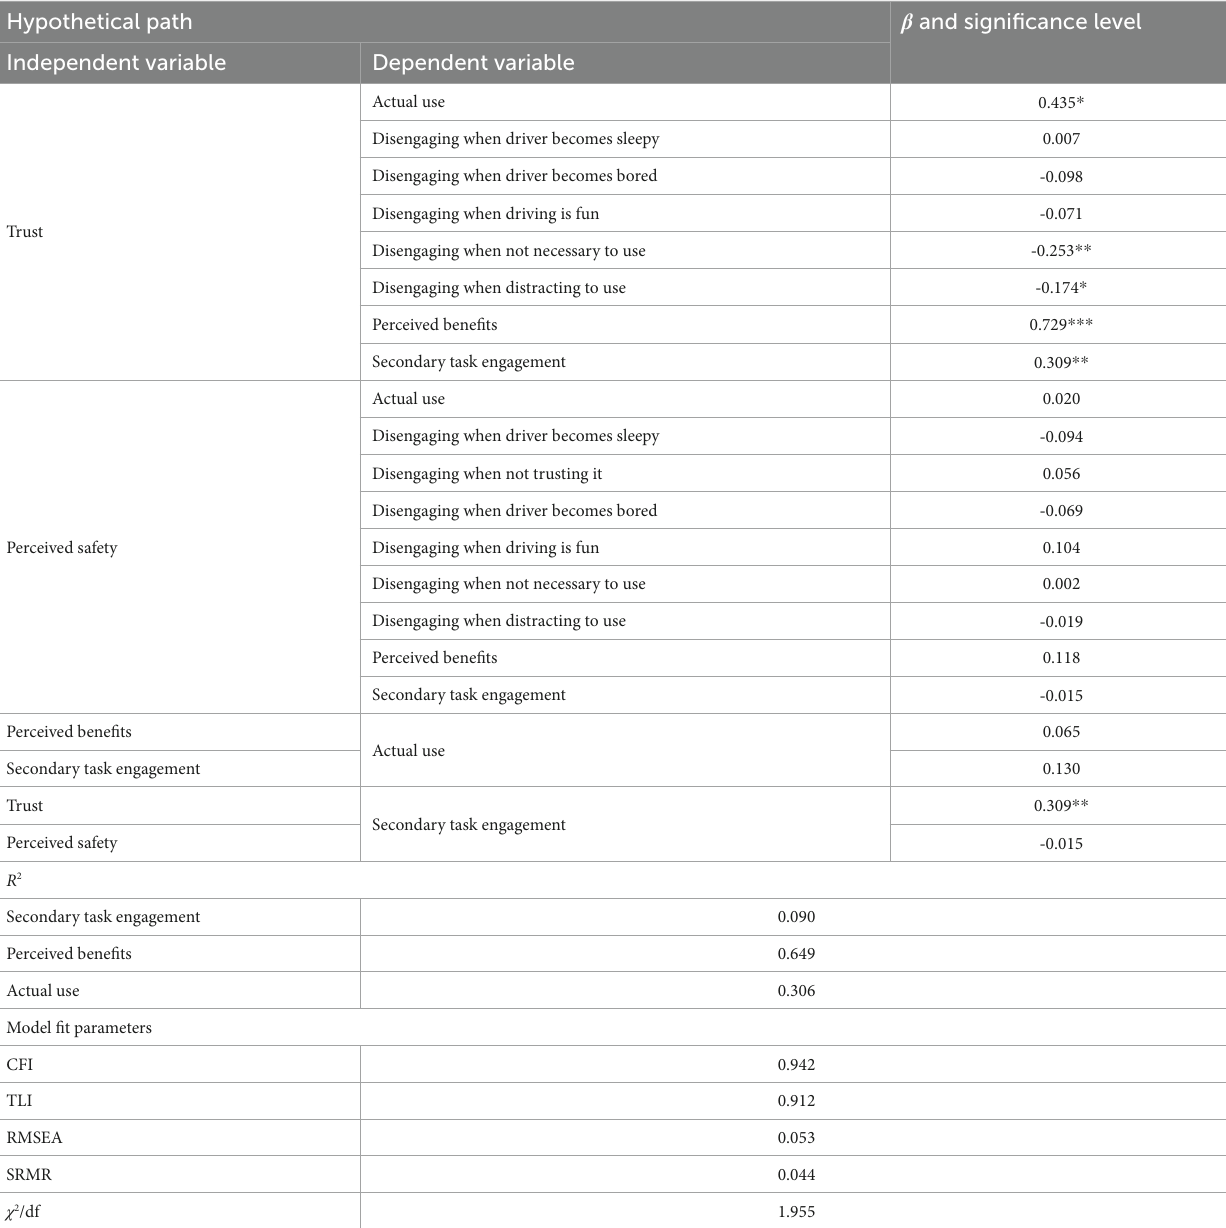
TABLE 6 Structural equation modelling results (i.e., β = standardized beta coefficients, significance level = *** p < 0.001, ** p < 0.01, * p < 0.05, all other correlations are not significant, R 2 = variance explained), main